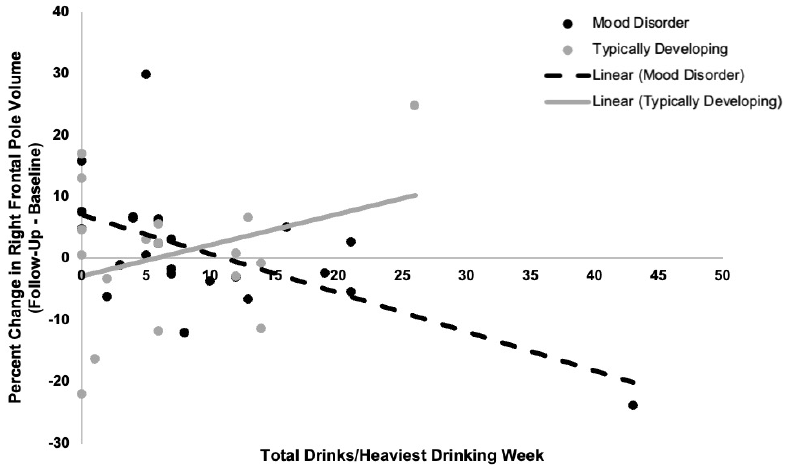
Figure 1. Relations between recent quantity of alcohol use (total drinks per week) and percent change in right frontal pole volume from baseline to follow-up in typically developing young adults and young adults with a mood disorder. A time-by-group-by-alcohol-use interaction on right frontal pole volume was observed ( p = 0.007). Greater recent alcohol use related to decreases in right frontal pole volume from baseline to follow-up assessments in young adults with a mood disorder (r 2 = 0.6, p = 0.0005). There was no significant relationship between recent alcohol use and change in right frontal pole volume from baseline to follow ‐ up in typically developing young adults ( p = 0.3).